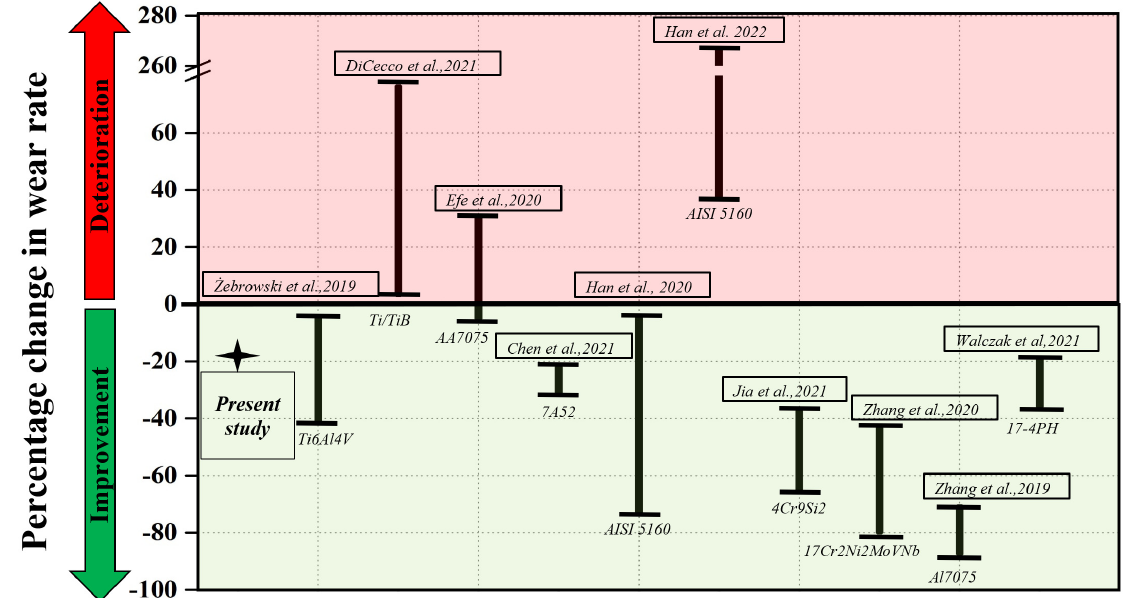
Figure 14. Comparison of percentage change in wear rate with literature [16–18,20–22,25,29,30,32] (details in Supplementary Materials).